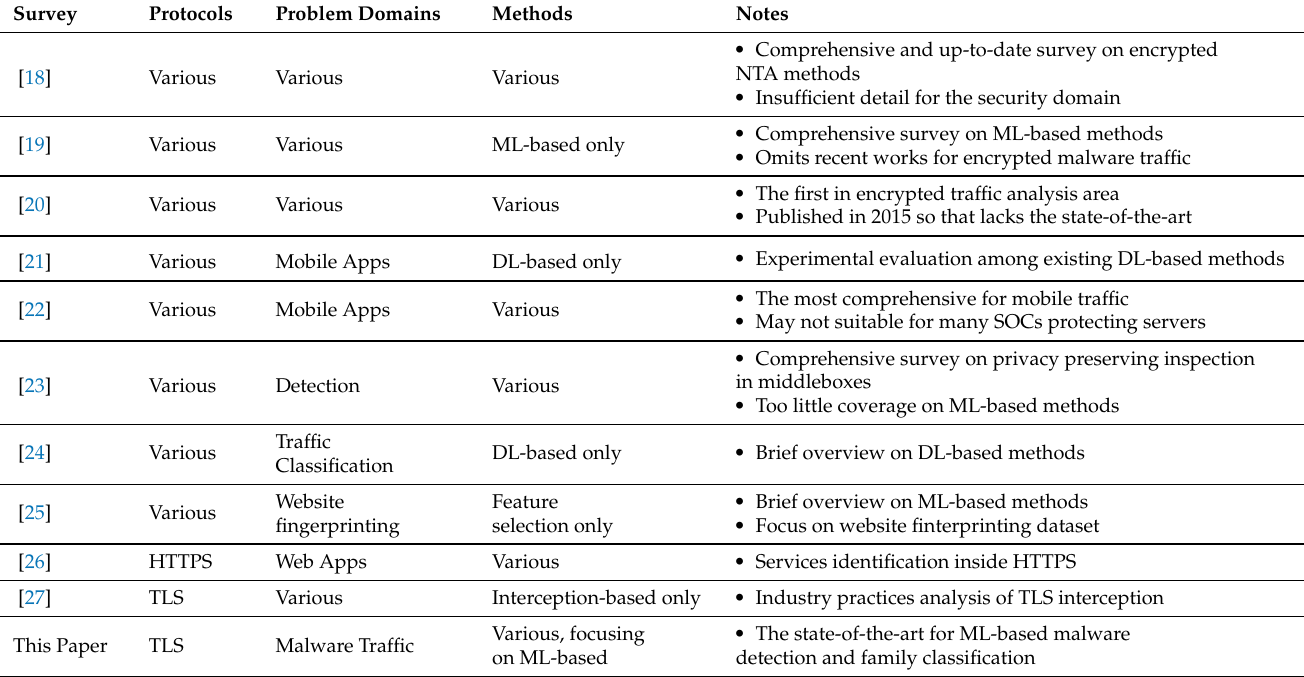
Table 1. A comparison of this paper with other related surveys, where ML refers machine learning and DL refers deep